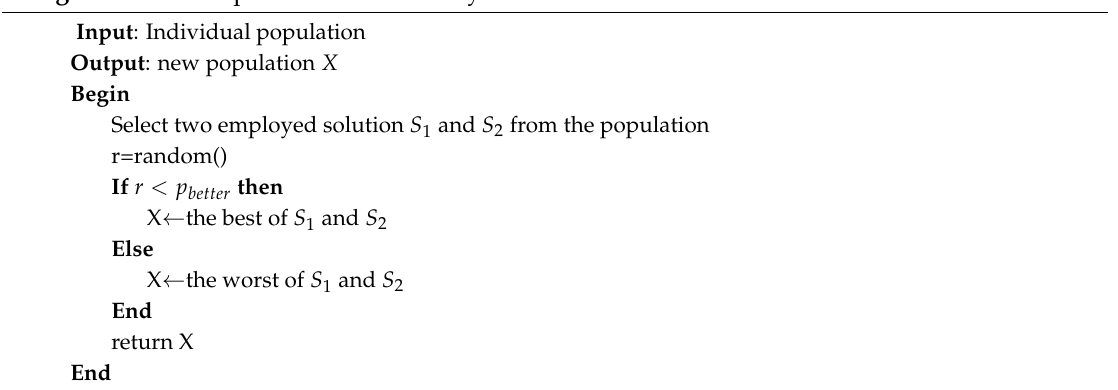
Algorithm 4: The pseudo-code of binary tournament